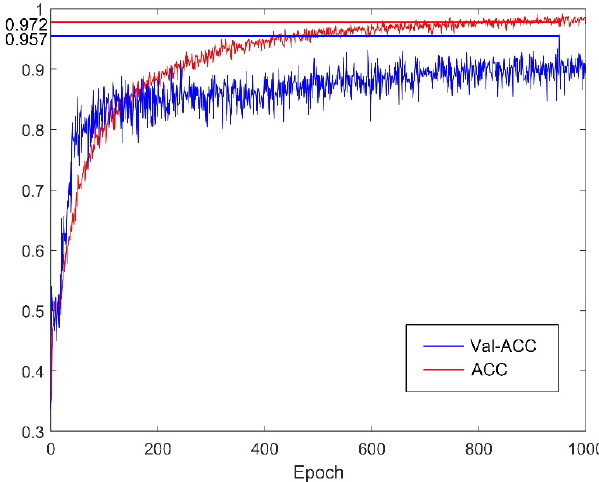
Fig. 4. The change curves of accuracy and validation accuracy.